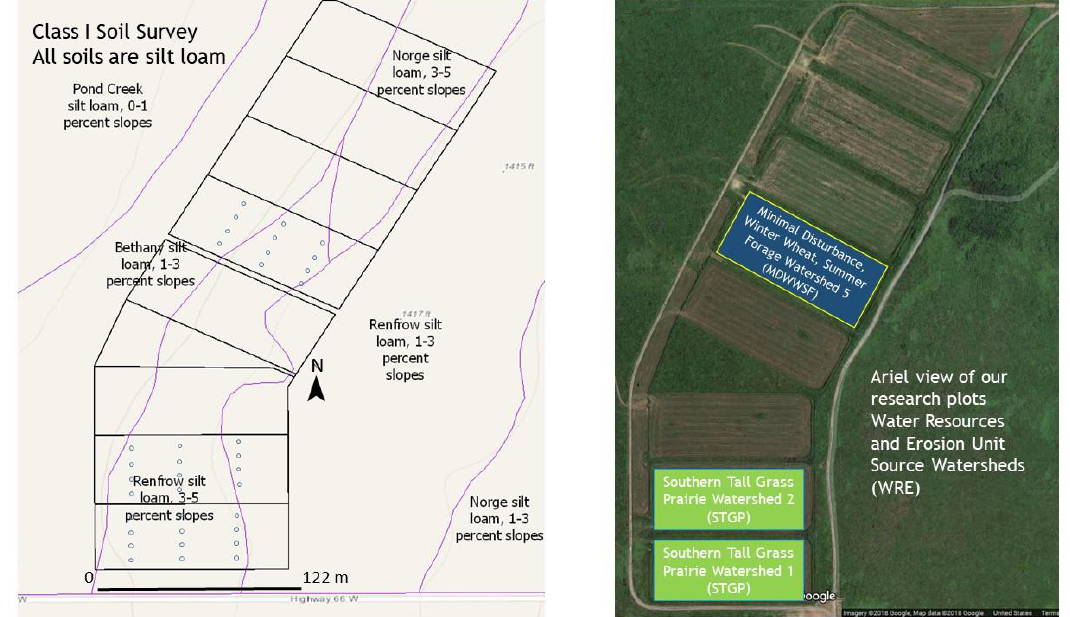
Figure 1. Four watersheds remained in southern tall grass prairie from 1976–2018. Circles on the class I soil survey each represent a 4.57 m × 3.9 m square sampling zone and are approximately but not exactly placed at the GPS points.